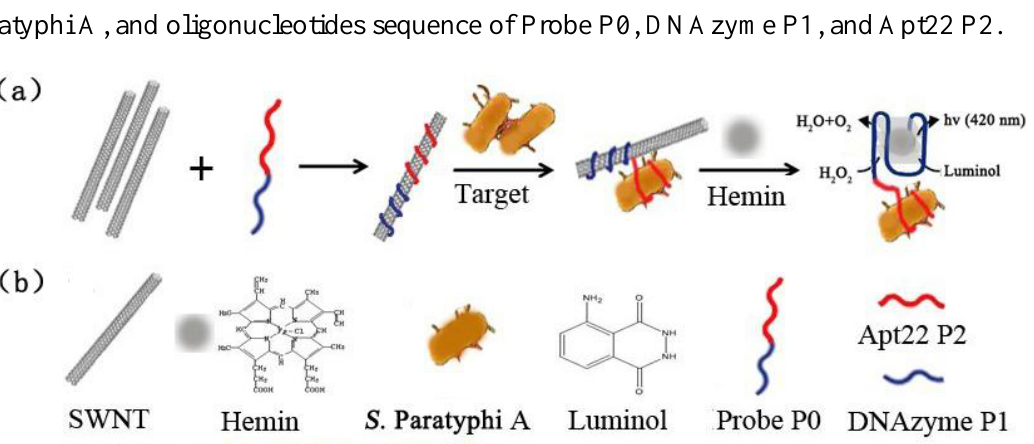
Figure 1. The detection method based on the noncovalent self-assembly of SWNTs and DNAzyme-labeled aptamer probe. ( a ) Scheme for detecting S. Paratyphi A. P0 wrap onto SWNTs to be a stable P0/SWNTs complex, then the target bacteria and hemin were added. P2 oligonucleotides specifically bind to target first and resulting in P0 keep away from SWNTs completely, and then a self-assembled formation of hemin/G-quadruplex horseradish peroxidase mimicking DNAzyme. And this self-assembled DNAzyme act as a catalyst for the generation of chemiluminescence ( λ = 420 nm) through the oxidation of luminol by H O , which results in an amplification of the detection signal. This signal will 2 2 be captured by fluorescence spectrometer. ( b ) Structures of Hemin, Luminol, SWNT, S. Paratyphi A, and oligonucleotides sequence of Probe P0, DNAzyme P1, and Apt22